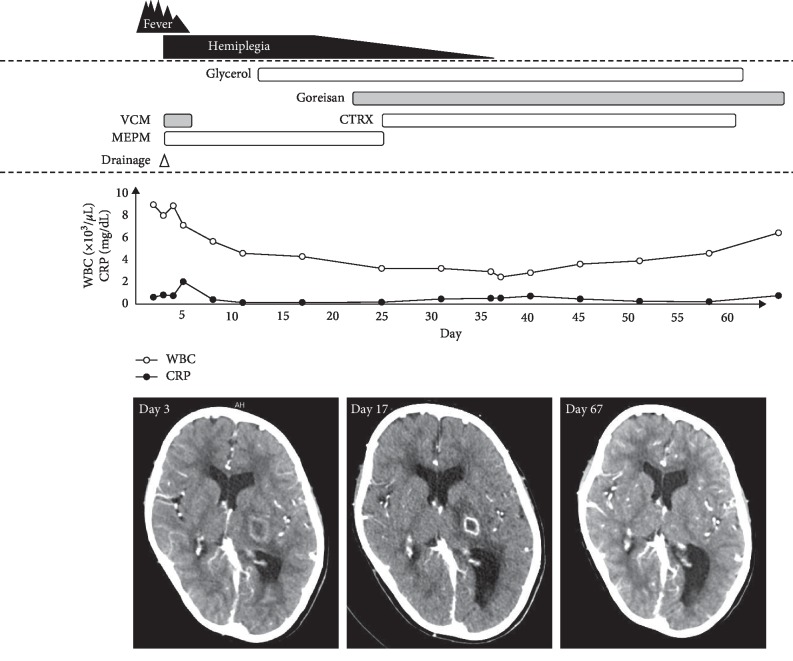
Clinical course of the patient. Neurological symptoms and computed tomography findings are improved by antimicrobial therapy, drainage, and antiedema therapy with glycerol and an herbal Kampo medicine goreisan. WBC, white blood cell count; CRP, C-reactive protein; CTRX, ceftriaxone; MEPM, meropenem; VCM, vancomycin.